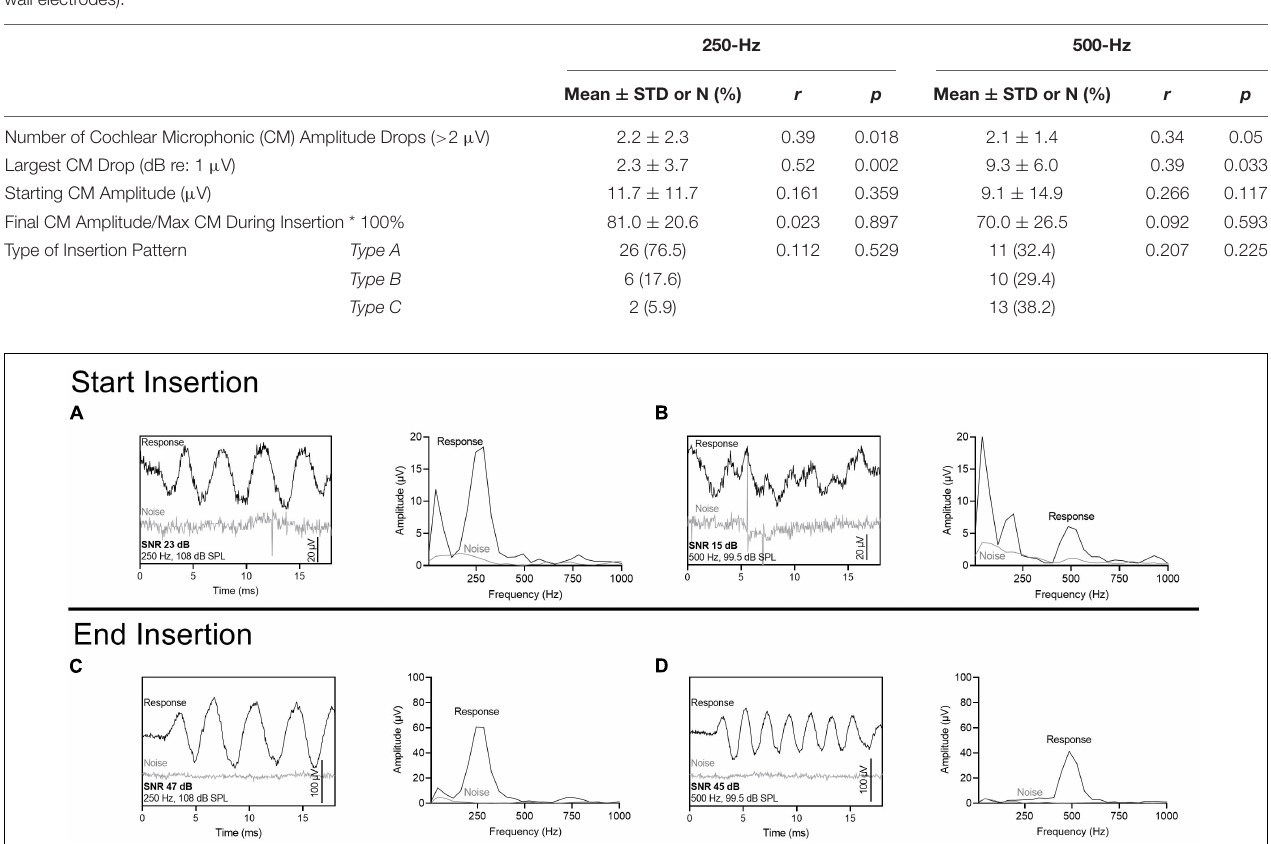
TABLE 2 | Comparison of multifrequency electrocochleography insertion trajectory parameters using 250- and 500-Hz acoustic stimulus and univariate linear regression with low-frequency pure tone average (125, 250, and 500-Hz) threshold shift from preoperative to 1-month post-activation for all insertions (both perimodiolar and lateral wall electrodes).